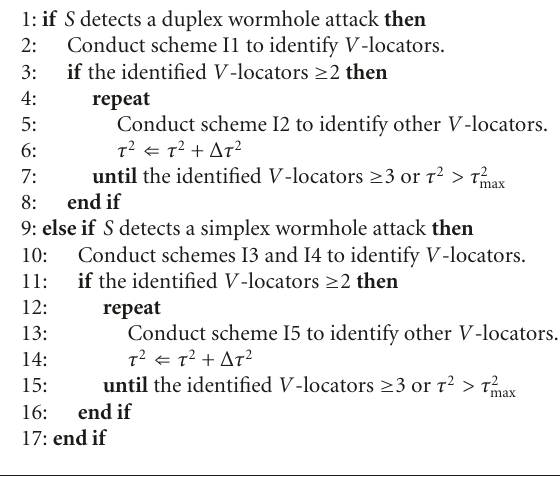
Algorithm 3: Enhanced Valid Locators Identification